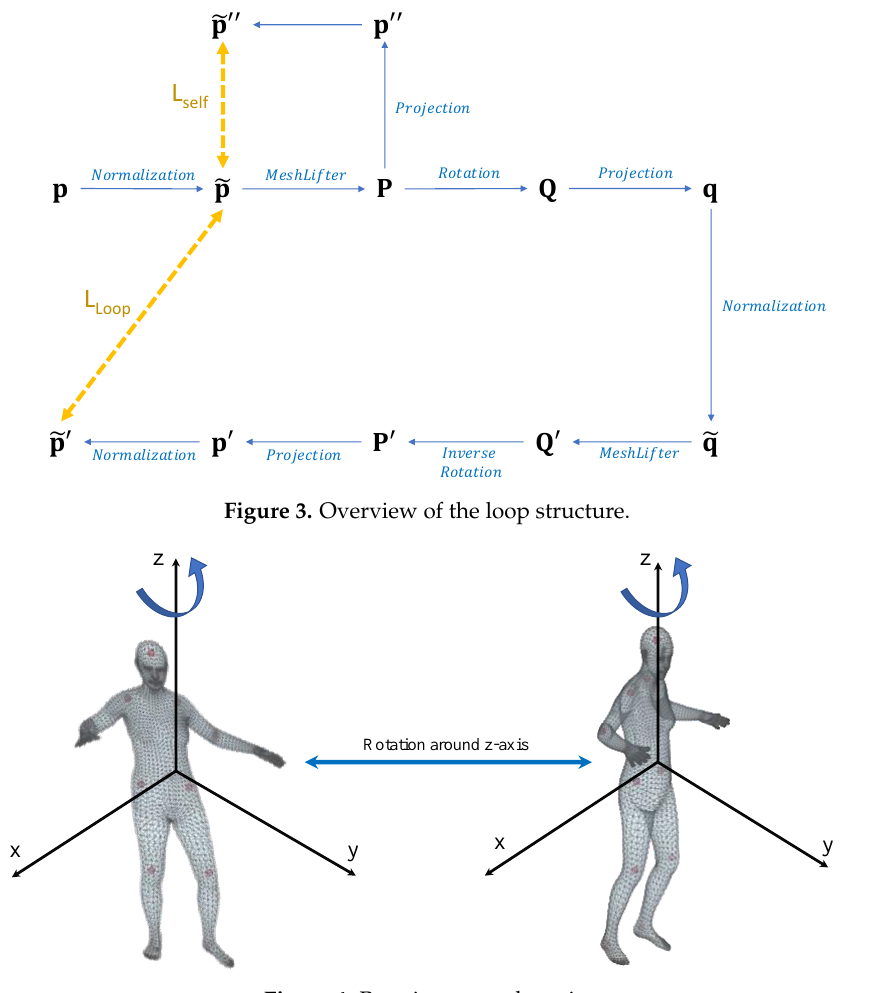
Figure 4. Rotation around z